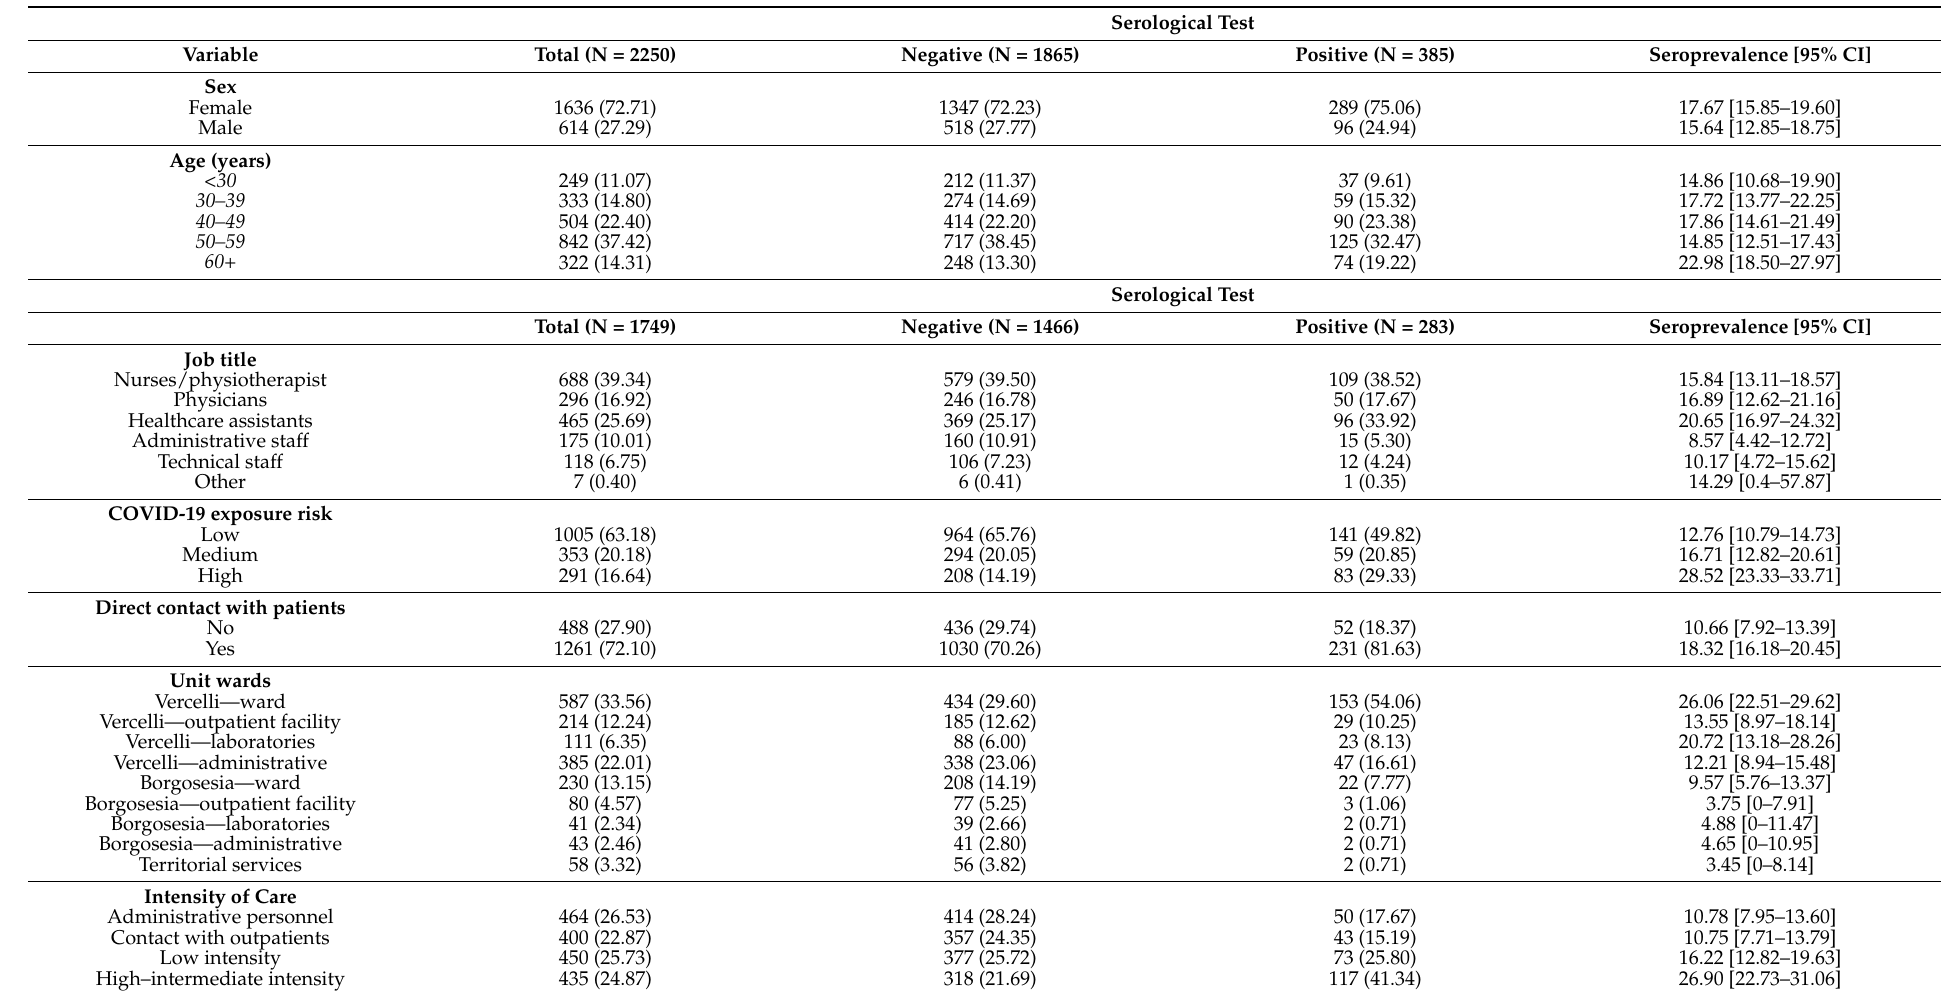
Table 1. Demographic and occupational characteristics of the 2250 workers in terms of serological test results. Absolute and percentage frequencies are